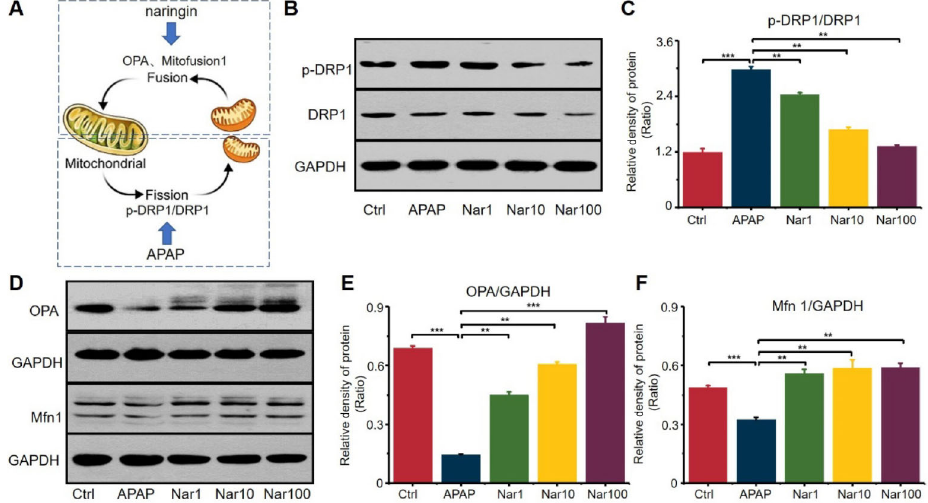
Figure 5. The effect of acetaminophen (APAP) and naringin (Nar) on mitochondrial dynamics. A , The equilibrium of mitochondrial dynamics. APAP promoted mitochondrial fi ssion and Nar promoted mitochondrial fusion. B and C , Western blot analysis of the effects of Nar and APAP on mitochondrial fi ssion (p-DRP1/DRP1). D , E , and F , Western blot analysis of the effect of Nar and APAP on mitochondrial fusion (OPA, Mfn 1). Data are reported as means ± SD (n=3). **P o 0.01 and ***P o 0.001 vs the APAP group (ANOVA).